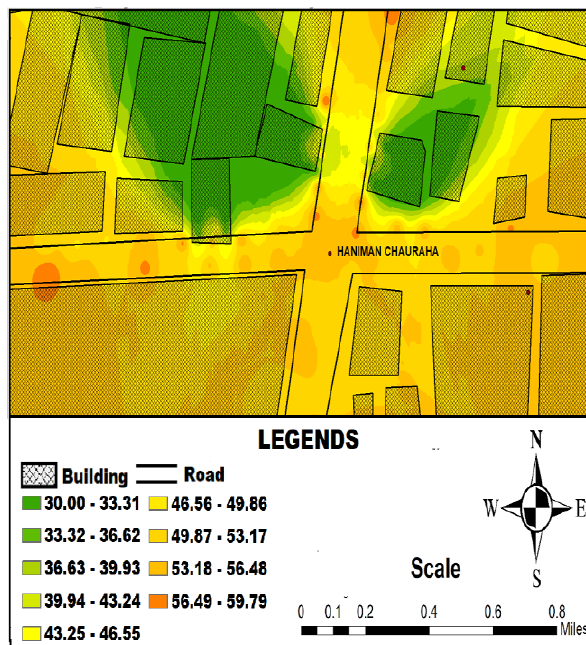
Figure 8. The noise map of Haniman Chauraha of the afternoon slot with value variation is between 30.00 to 59.79. Barrier and distance attenuation is also calculated and mapped.